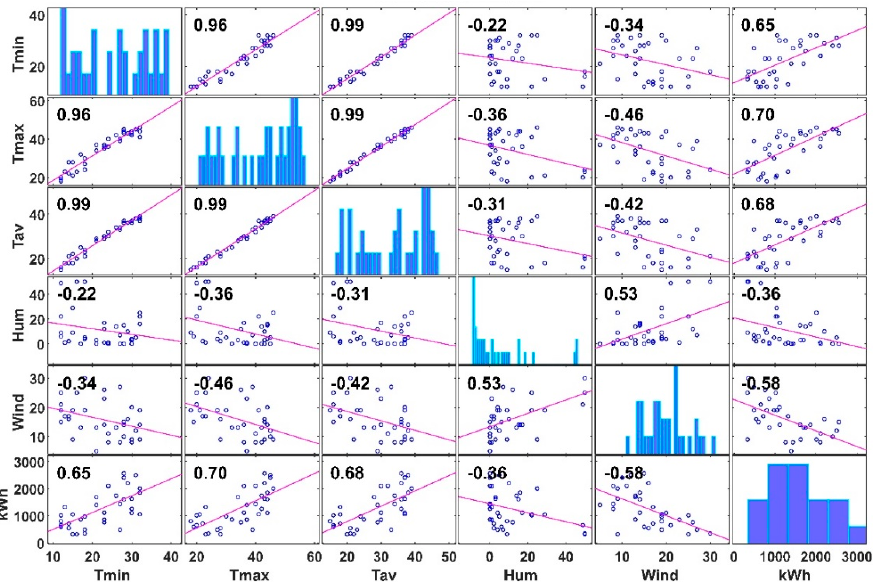
Figure 8. Correlation matrix used for feature selection.